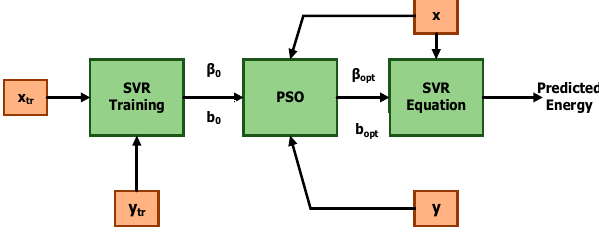
Figure 7. Block diagram of conventional PSO tuned support vector regression-based prediction system. Table 7. Values of β opt , b opt Determined by the PSO Method.